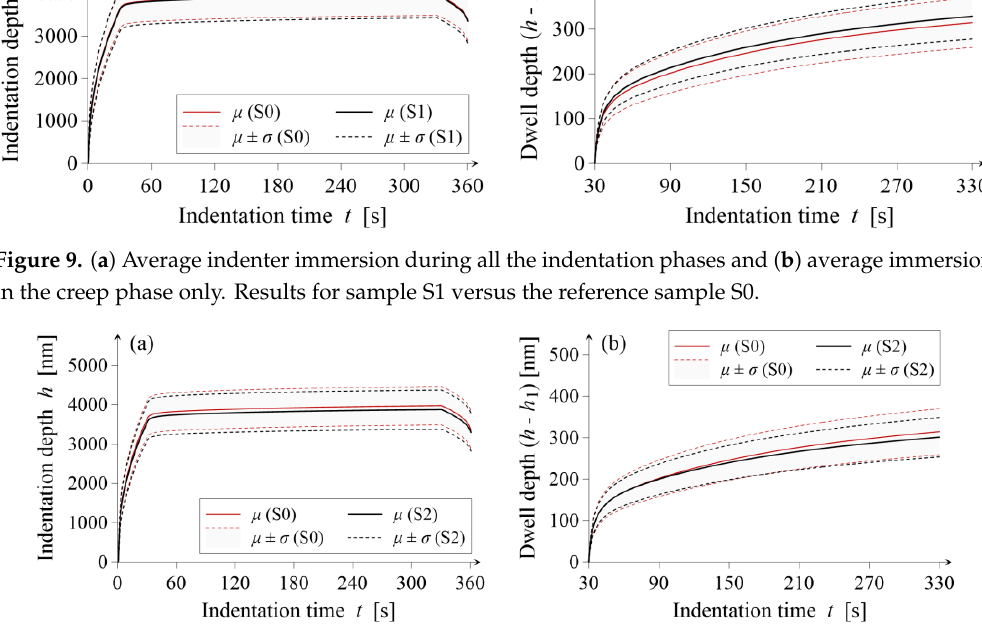
Figure 10. ( a ) Average indenter immersion during all the indentation phases and ( b ) average immersion in the creep phase only. Results for sample S2 versus the reference sample S0.